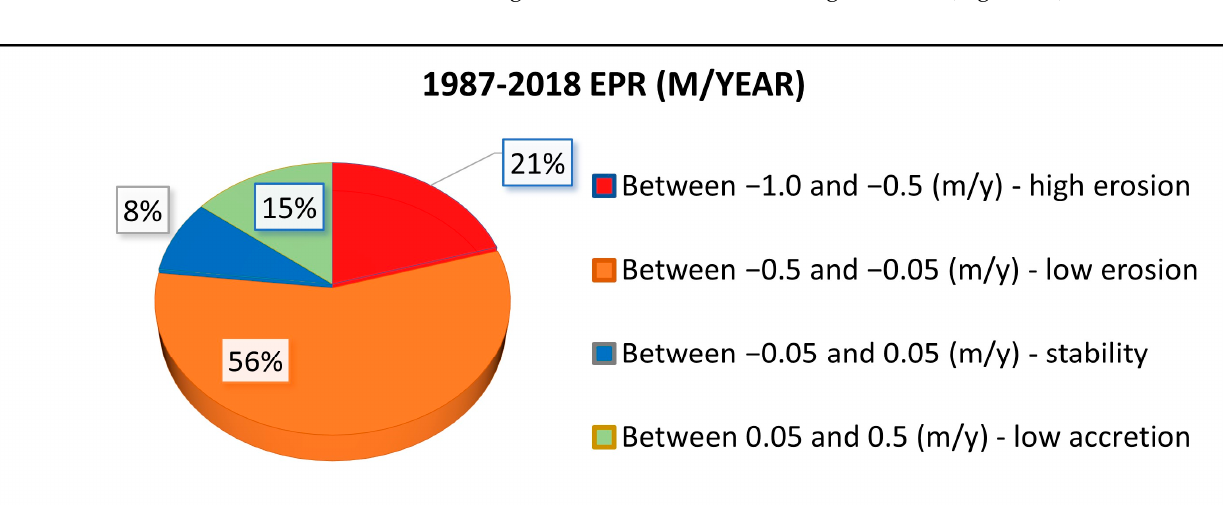
Figure 12. (%) State of erosion as part (%) of the study area according to the EPR rates (1987–2018).